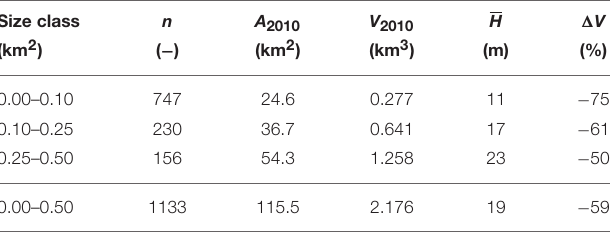
TABLE 2 | Characteristics of very small glaciers in the Swiss Alps for three size